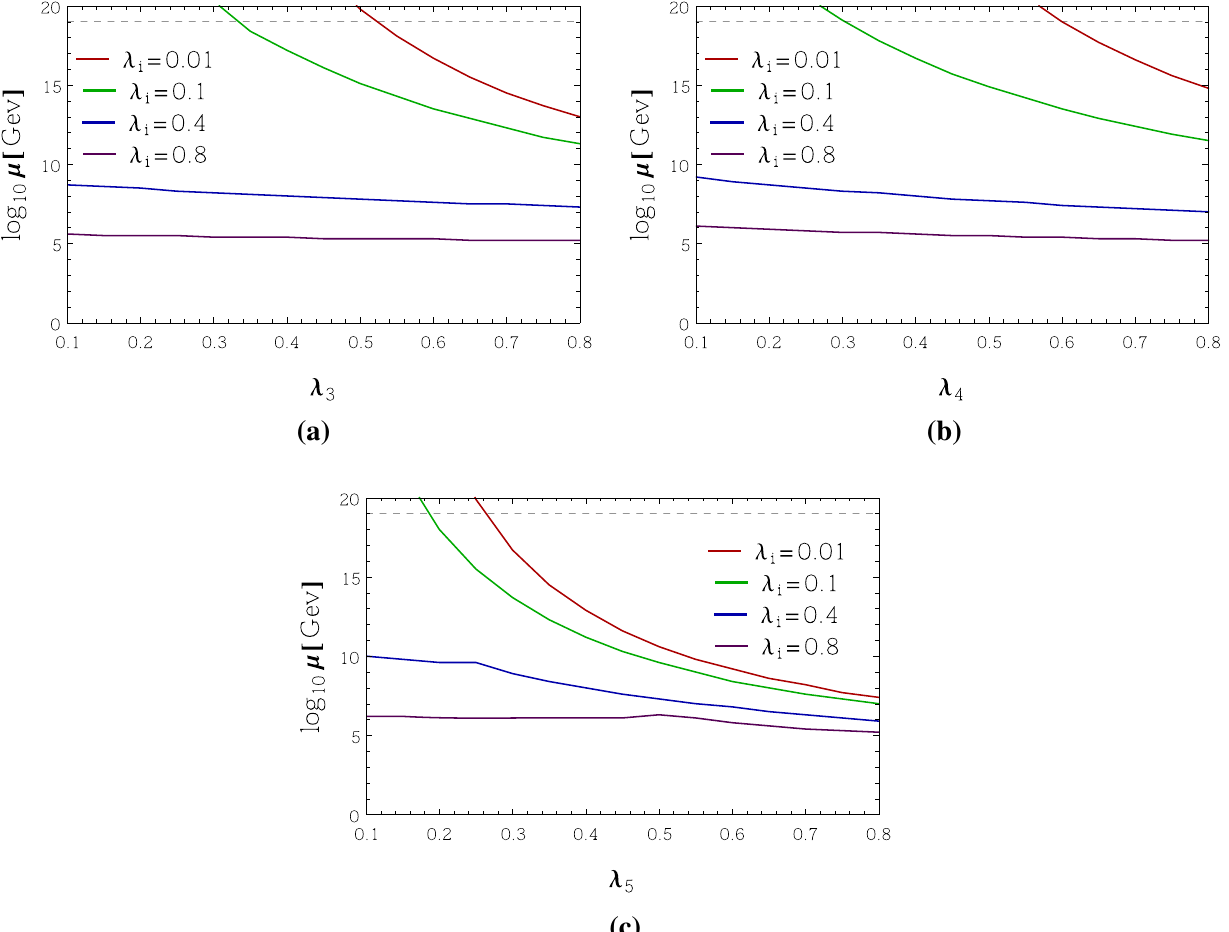
i = 2 , 3 , 4 , 5) at the EW scale, representative of very weak ( λ i = 0 . 01),